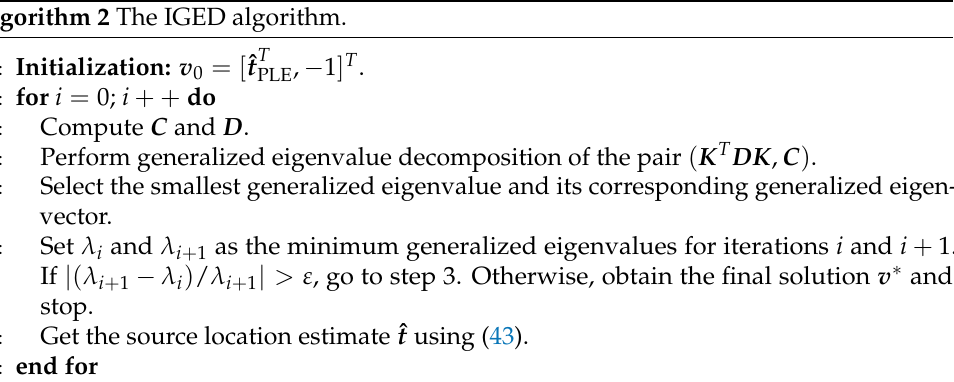
Algorithm 2 The IGED